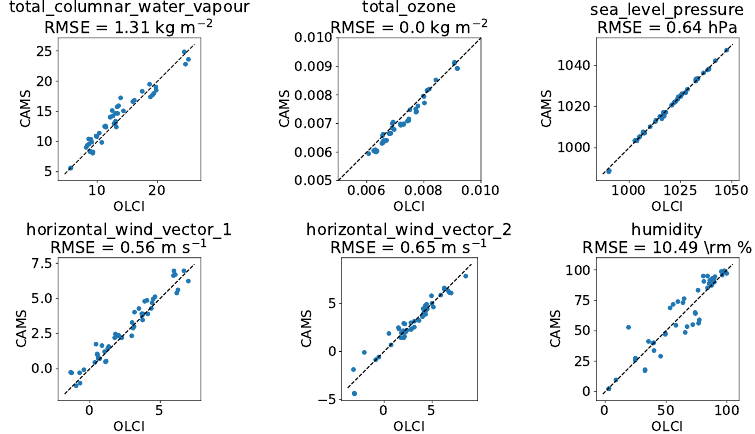
Figure 7. Comparison of CAMS-derived (y-axis) and in-product (x-axis) meteorological data.